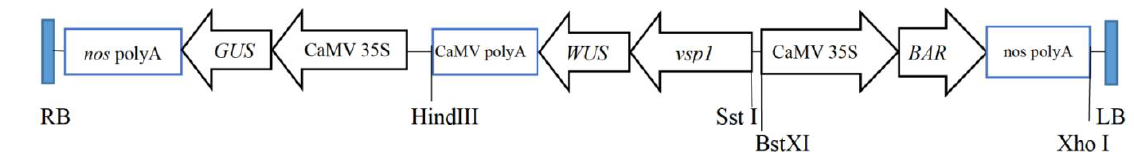
Figure 10. Organization of the T-DNA of plasmid pCambia1301- WUS - bar . Arrows represent promoters and coding sequences. Rectangles represent polyA regions. Restriction sites used for the construction are also indicated.